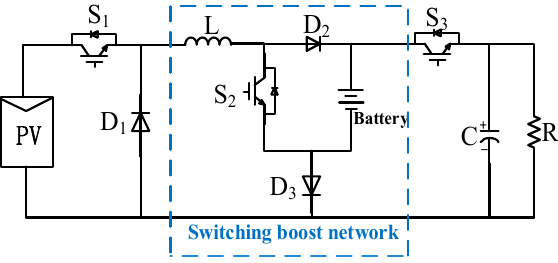
Figure 1. Buck–boost integrated dual active bridge three-port DC–DC converter.